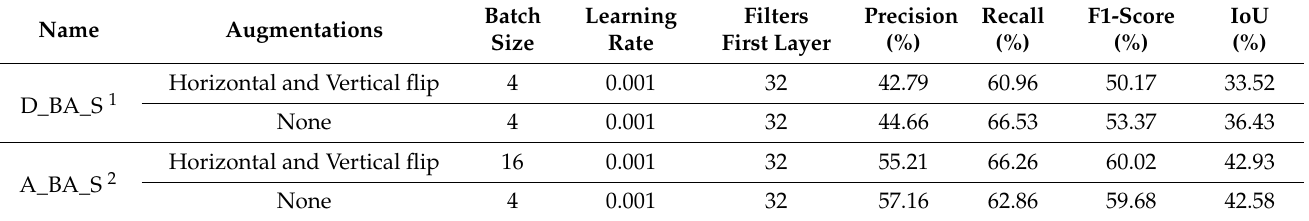
Table 4. Performances and best hyperparameters for Attn-U-Net and BA_S datasets, with and without augmentations.